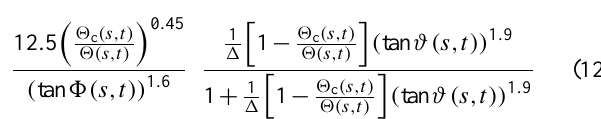
Fig. 10. Third stage. Mean sediment concentration in time ( C v ) against moving layer (measured) depth ( h s ). Among C v measures on the last embankment section, s L , are reported the C v computed , 0 by Eq. (12) for all inner ) against moving layer Figure 10. Third stage. Mean sediment concentration in time ( C v ). Among C measures on the last embankment section, s , are reported (measured) depth ( h s v L the C computed by Eq.(12) for all inner sections. v